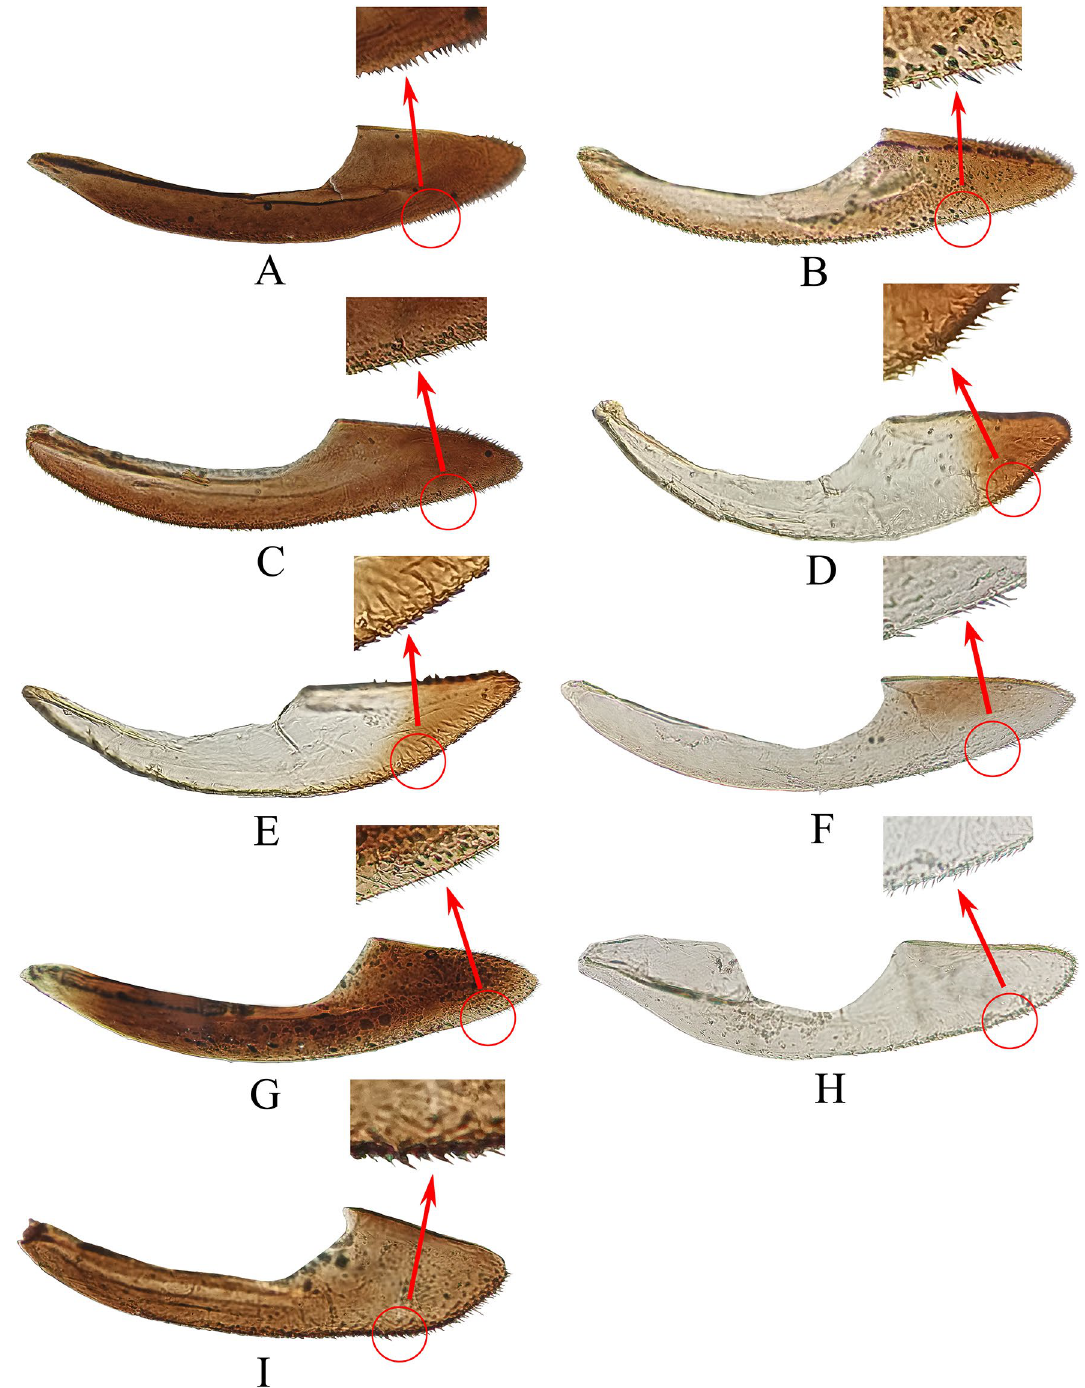
Figure 8. Female valvula III: (A–I) : (A) Mitjaevia protuberanta . (B) Empoascanara sipra . (C) Empoascanara dwalata . (D) Cassianeura cassiae . (E) Cassianeura bimaculata . (F) Eupteryx minuscula . (G) Eupteryx gracilivramus . (H) Limassolla lingchuanensis . (I) Zyginella minuta